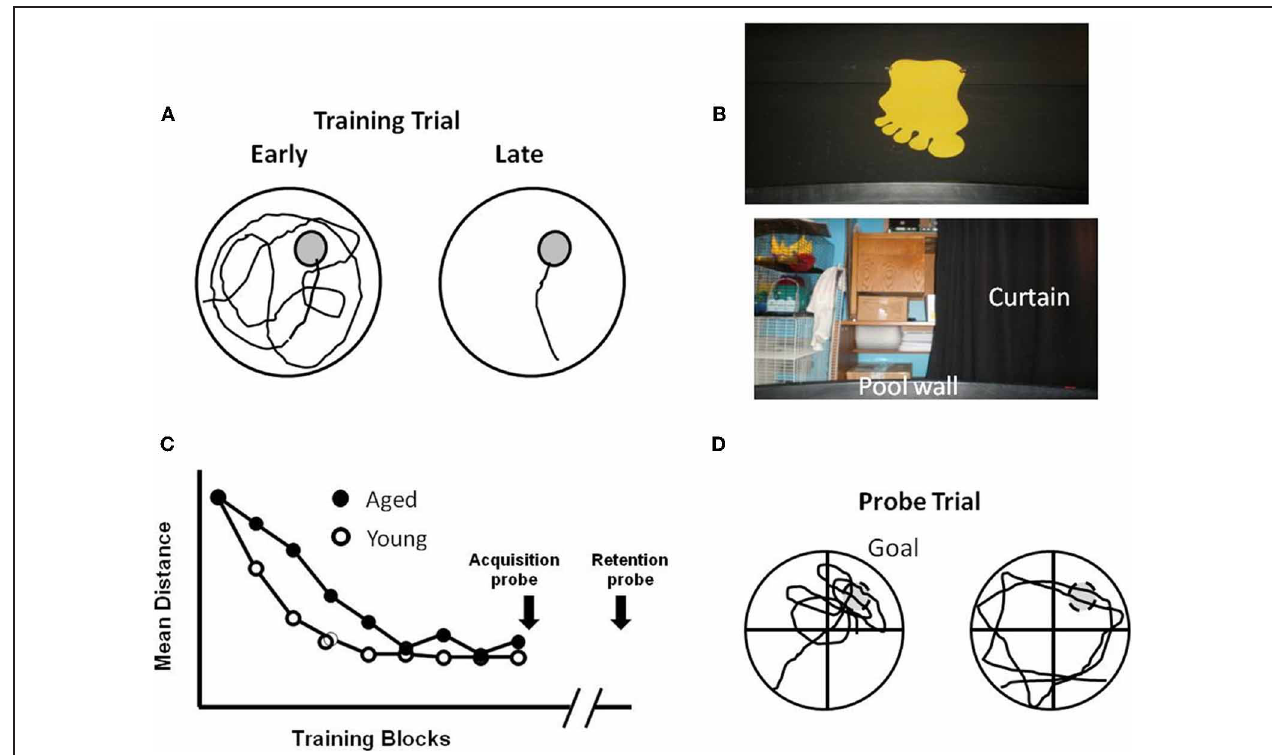
FIGURE 1 | Performance differences during aging for training on the water maze. (A) Schematic illustration of the pool, with an escape platform (gray circle) in the upper right hand quadrant. The line indicates the path length to find the platform, which decreases from the earlier to later training trials. (B) Spatial cues include posters attached to the room walls, equipment within the room, and lights. In addition, a large black curtain can be pulled around the pool to limit spatial cues. (C) Performance curves for young and aged animals illustrating similar performance on the first trial block. Young animals quickly learn the location of the platform, reducing the distance traveled to escape.